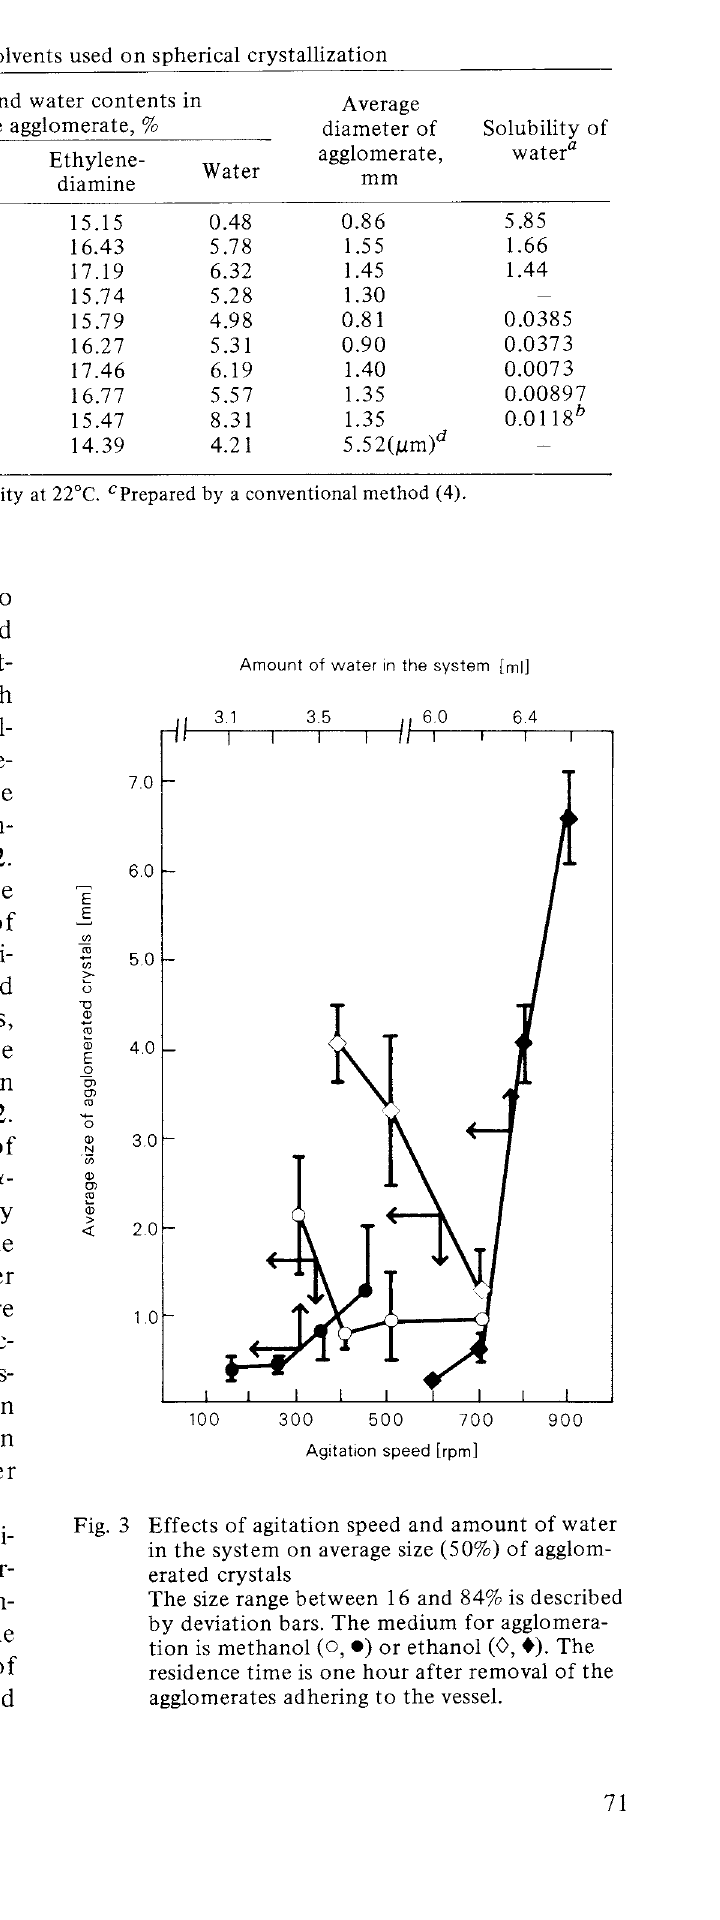
Table 2 Effect of organic solvents used on spherical crystallization Drug and water contents in Average Water in the agglomerate,% diameter of Solubility of Organic the system, solvent